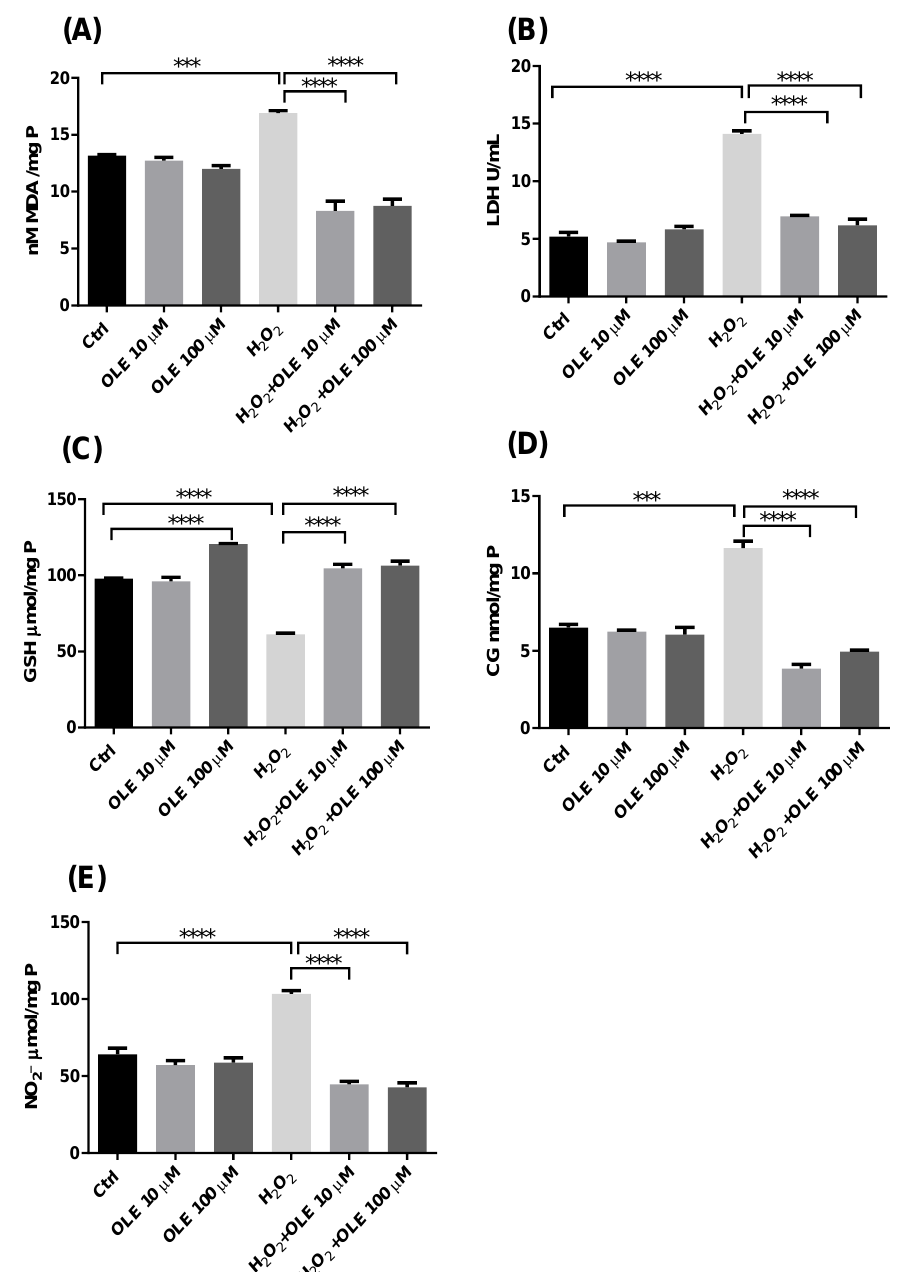
Figure 5. The effect of oleuropein (OLE) on lipid peroxidation and protein damage in H 2 O 2 -exposed HTR-8/SVneo cells. The investigated parameters include malondialdehyde (MDA) concentration ( A ), extracellular lactate dehydrogenase (LDH) activity ( B ), reduced glutathione (GSH) concentration ( C ), protein carbonyl group (CG) concentration ( D ) and nitrite (NO 2 − ) concentration ( E ). The data are expressed as mean + SEM., *** p < 0.001, **** p < 0.0001. The GSH content analysis shown in Figure 5C indicated that the treatment of cells with OLE 100 µM alone can provide a significant rise in GSH concentration, increasing